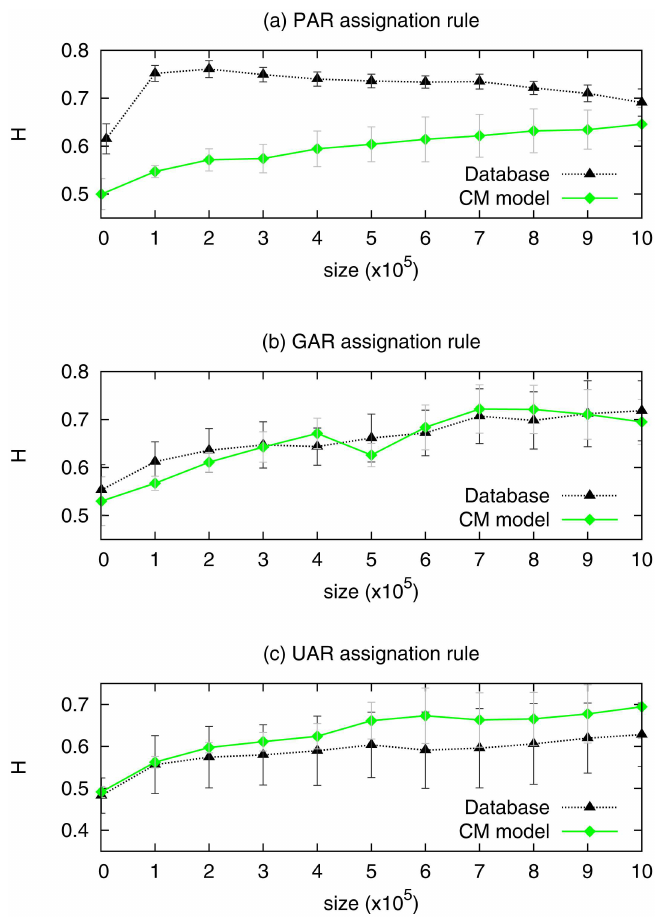
Fig 4. Hurst exponent obtained by the DFA method as a function of the length of the time series in the database (dotted black line with triangles), and generated with CM, p = 0.005 and τ c = 96 (full green line with diamonds): (a) using the PAR; (b) using the GAR; and (c) using the